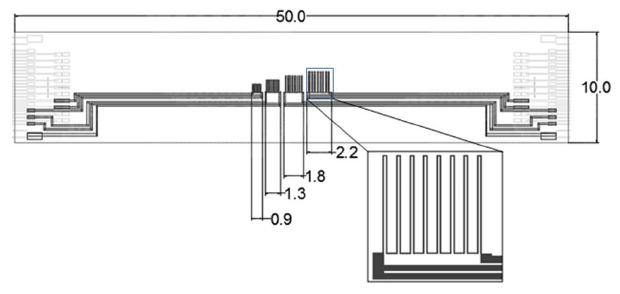
Figure 3. A typical sensor layout, with four resistive structures, on one of the steel inlays. Dimensions are in